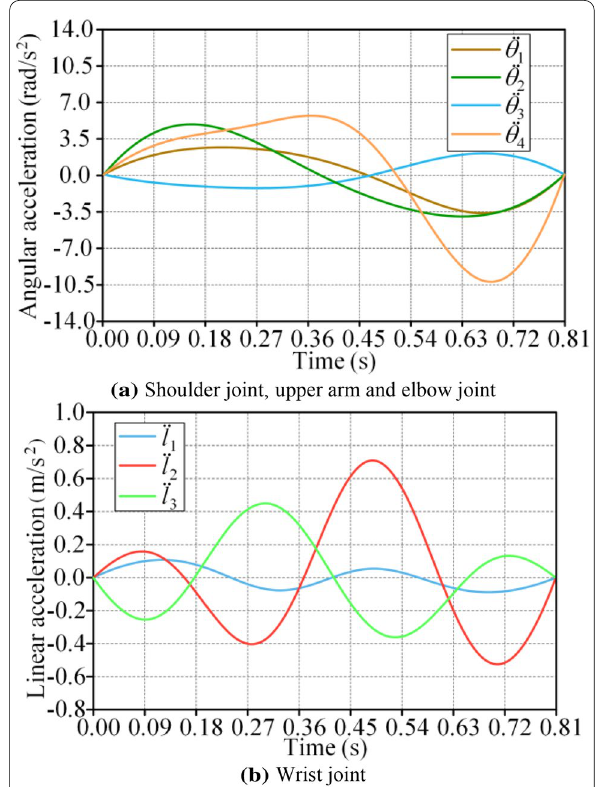
Figure 11 The acceleration profile of each joint using composite polynomials